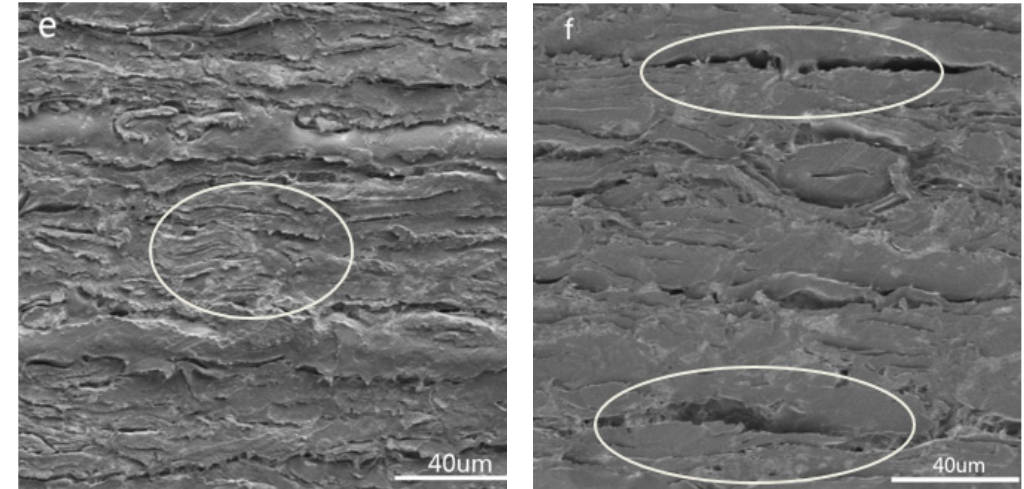
Figure 5. Microscopic morphology after magnifying 500 times of composite materials at di ff erent temperatures and di ff erent paper contents: ( a ) hot-pressing temperature: 170 ◦ C; ( b ) hot pressing temperature: 190 ◦ C; ( c ) hot-pressing temperature: 200 ◦ C; ( d ) paper content: 47.6%; ( e ) paper content: 62.5%; ( f ) paper content: 69.4%.